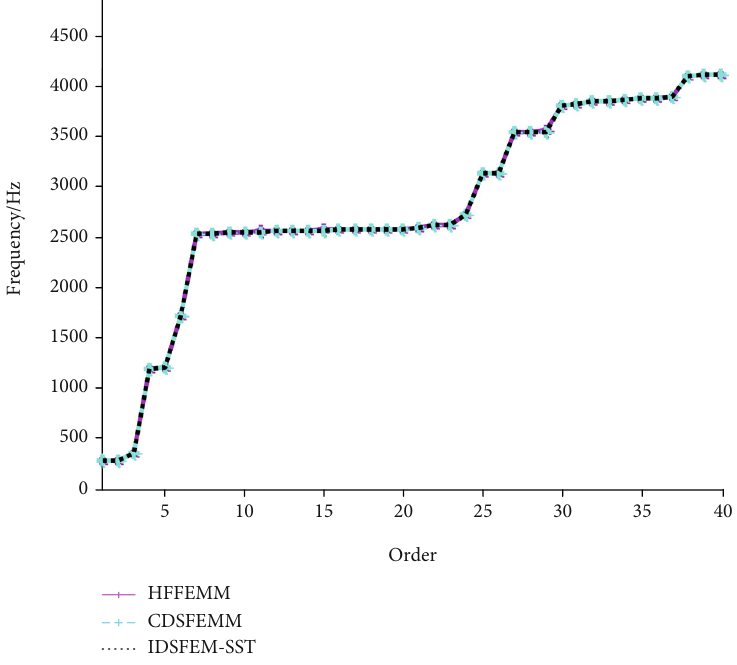
Figure 4: Modal frequencies